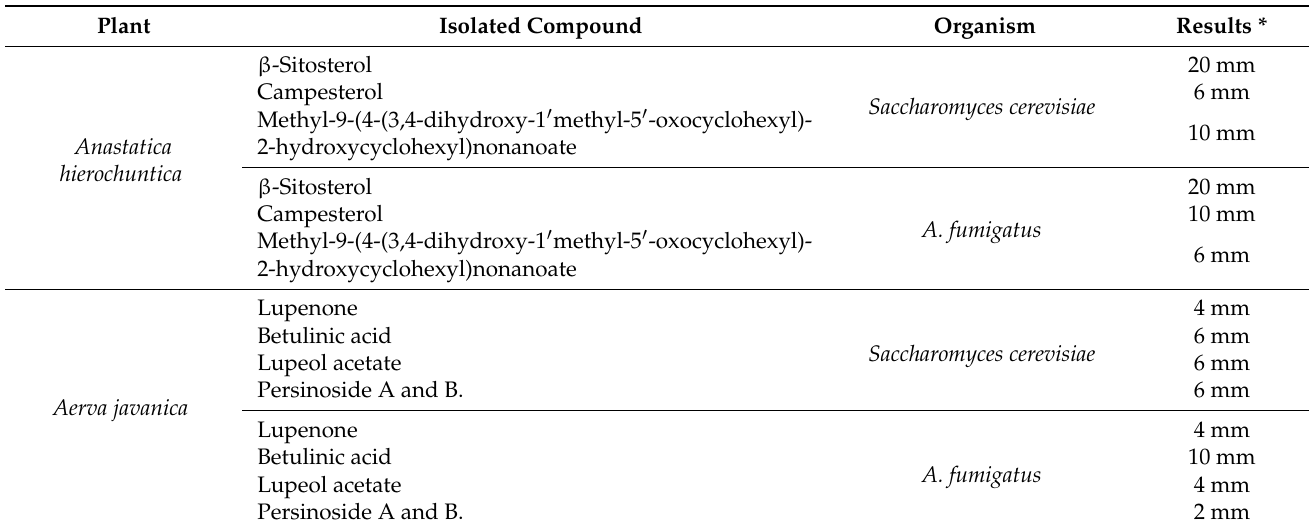
Table 6. Antifungal activity of metabolites identified in acetone extracts of Anastatica hierochuntica and Aerva javanica